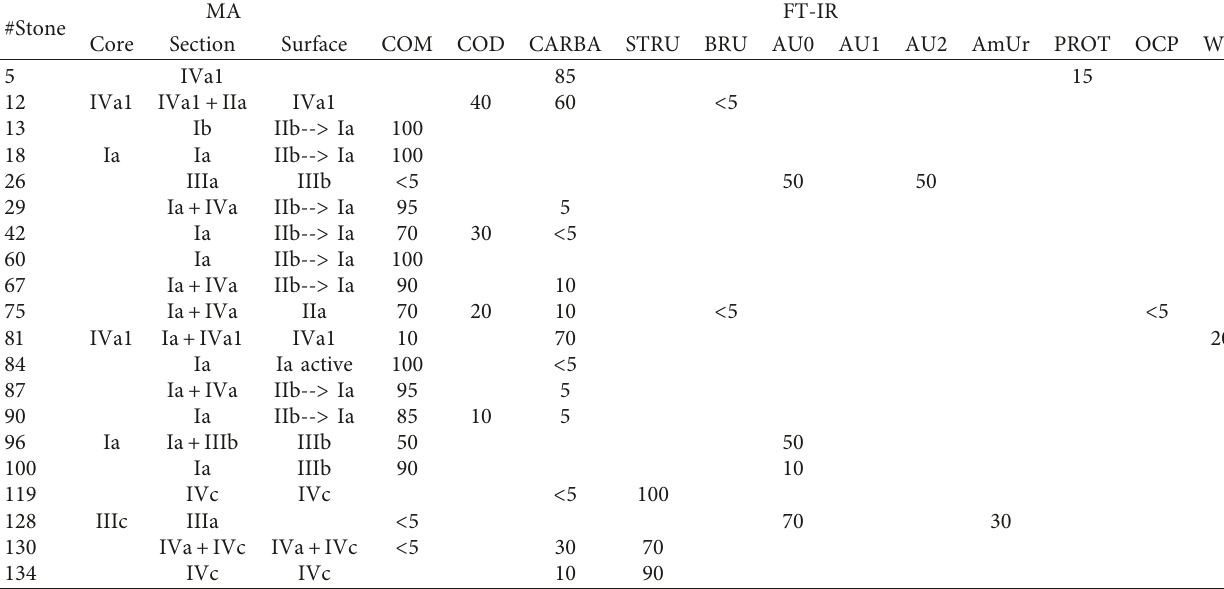
Table 5: Composition for the 20 discordant results observed by MA and